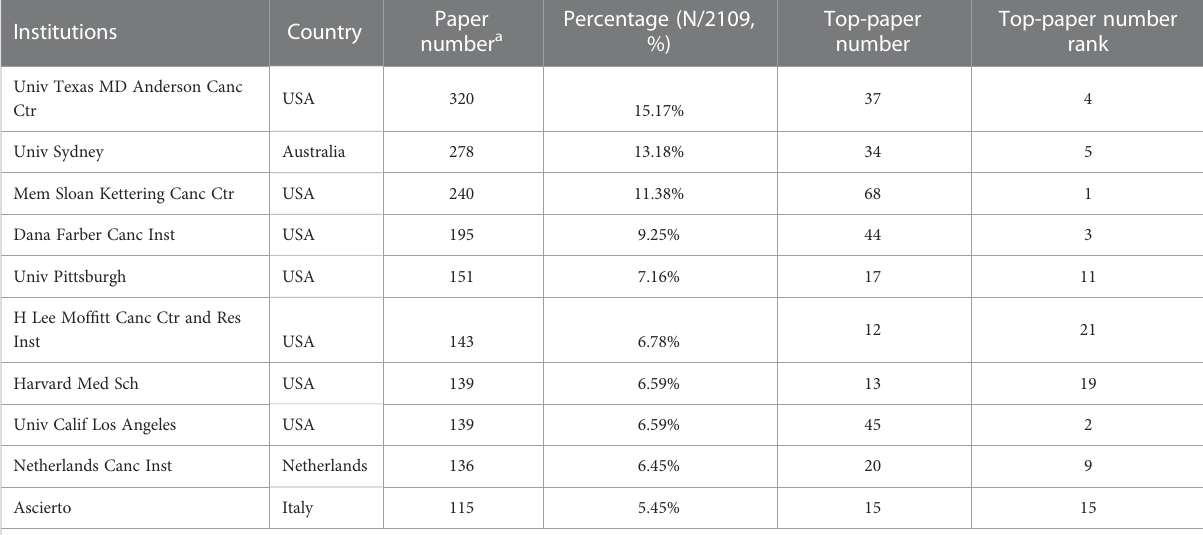
TABLE 5 The top 10 productive institutions in melanoma immunotherapy between 2010 and